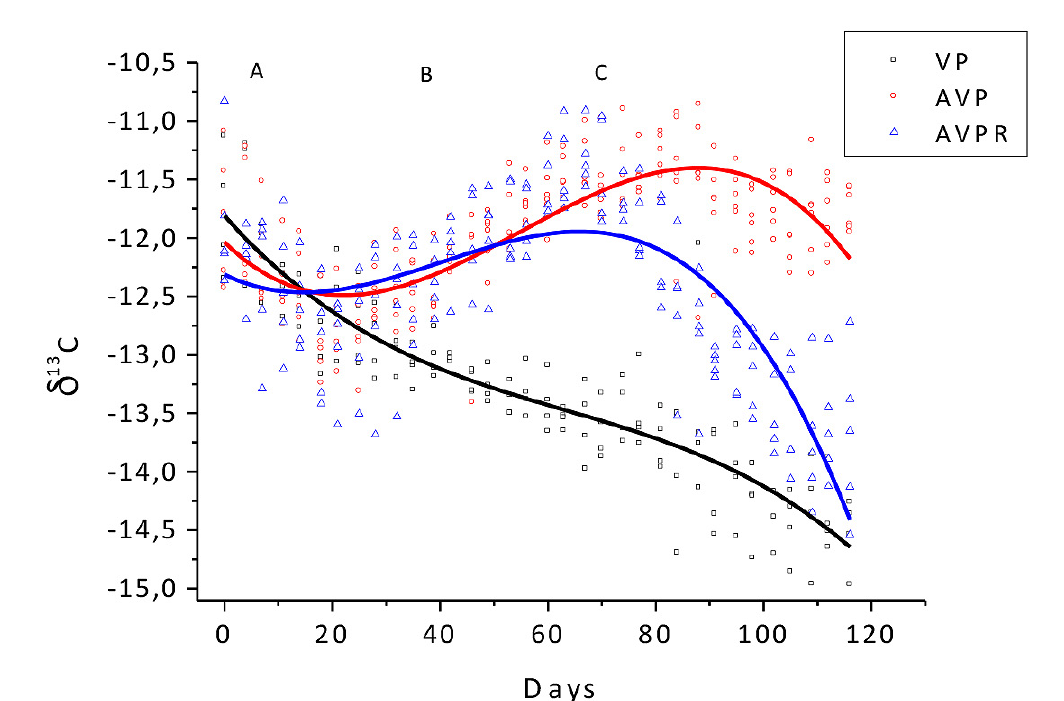
Figure 1. Animal feed δ 13 C measurement. A: adaptation period; B: period in which the AVP and AVPR groups received diet with animal protein; C: period in which the AVPR group received a strictly vegetable